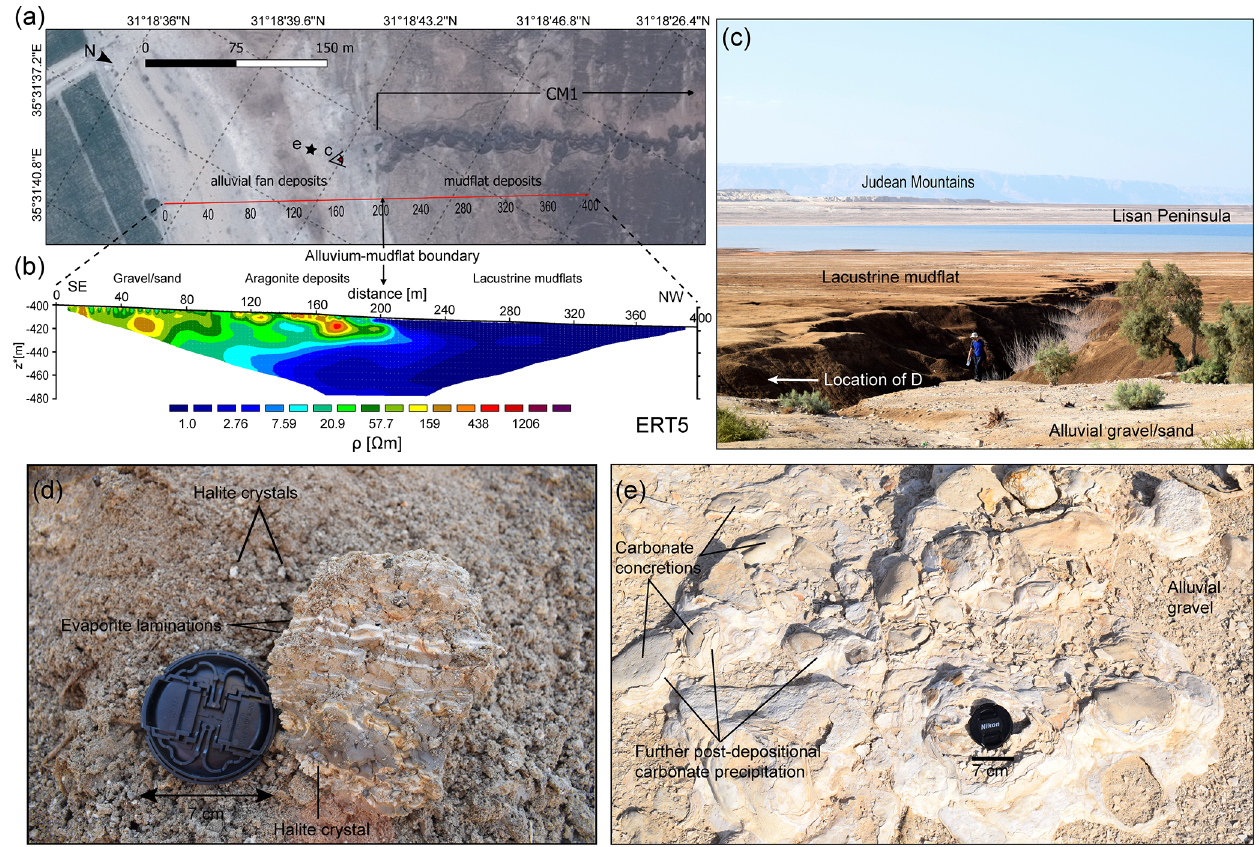
Figure 10. ERT line 5 along the dry stream channel CM1 at the interface between alluvium and lacustrine sediments and associated surface manifestations. The survey used an inter-electrode distance of 5m in a Wenner configuration. (a) Pleiades satellite image from April 2018 near canyon CM1 showing the profile location. (b) Electric resistivity distribution achieved by inversion of apparent resistivities. An rms of 7.5% was achieved after six iterations. (c) Field photo from October 2018 looking NW along channel CM1, with contact between the alluvial fan deposits and the mudflat deposits of the former lake bed visible in the foreground near to the trees. Person for scale. The Lisan Peninsula and the Judean Mountains on the Dead Sea’s western shore are visible in the background. (d) Hand specimen of the former lake- bed deposits from the bank of channel CM1; see part (c) for the location. Lens cap for scale. (e) Post-depositional carbonate concretions in the alluvial fan deposits; see part (a) for the location. Lens cap for scale. The minerals deposited are a mixture of aragonite, calcite, gypsum and clay minerals, all derived from the marls of the Lisan Formation. This degree of cementation is remarkable for the alluvium and is likely responsible for the elevated resistivity of the shallow subsurface at this